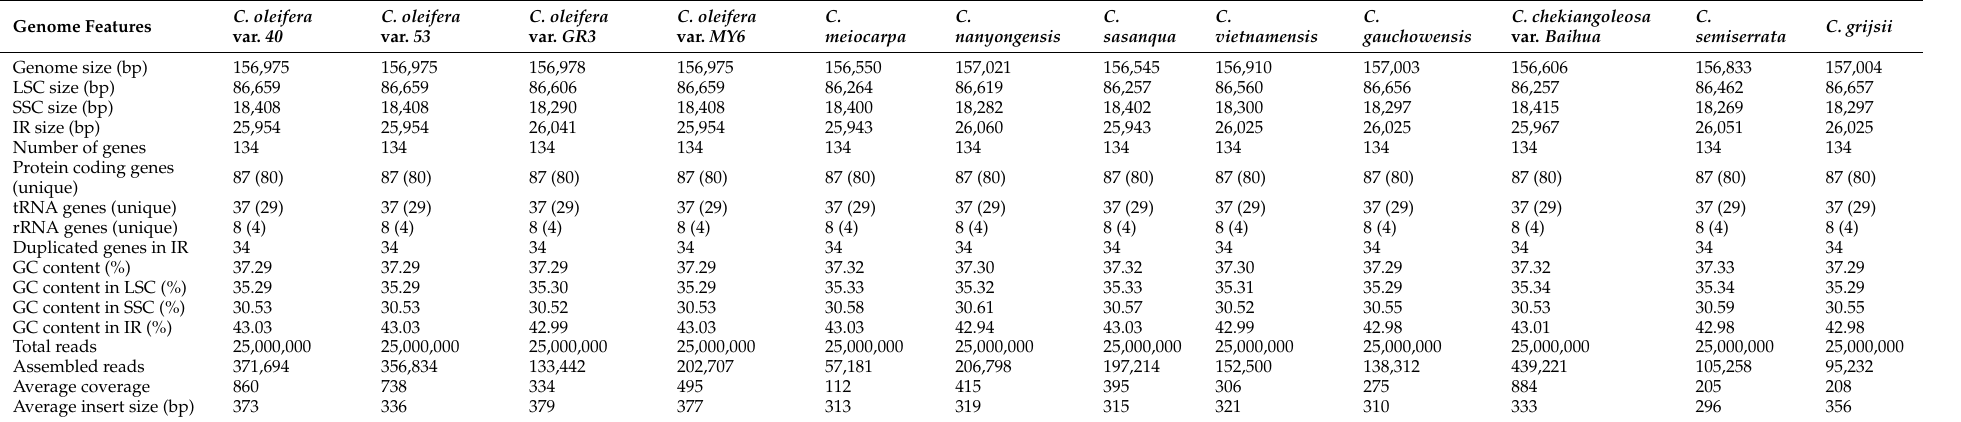
Table 2. A summary of the statistics for the chloroplast genomic assemblies of 12 Camellia species and